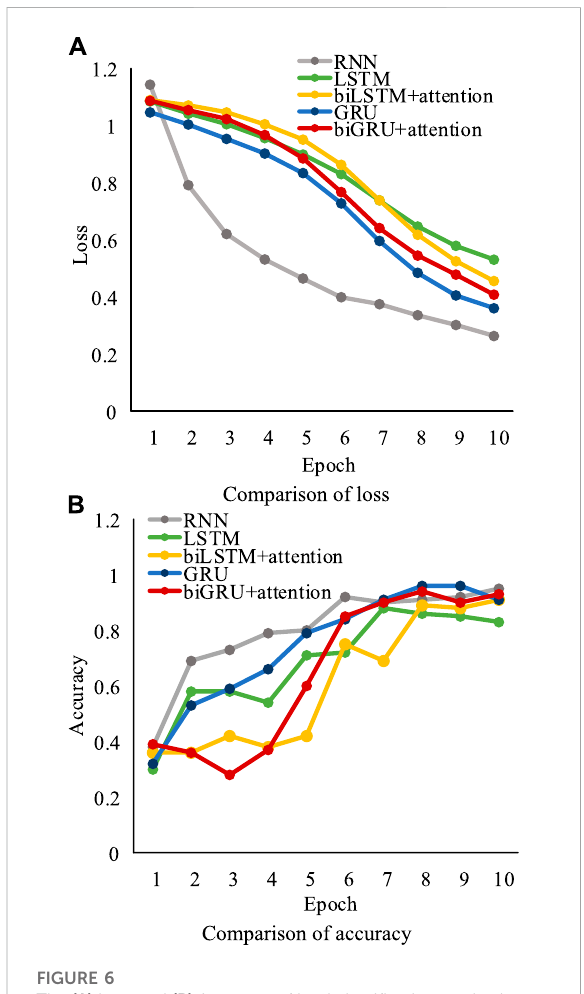
FIGURE 6 The (A) Loss and (B) Accuracy of load classi fi cation methods using the Iris dataset.